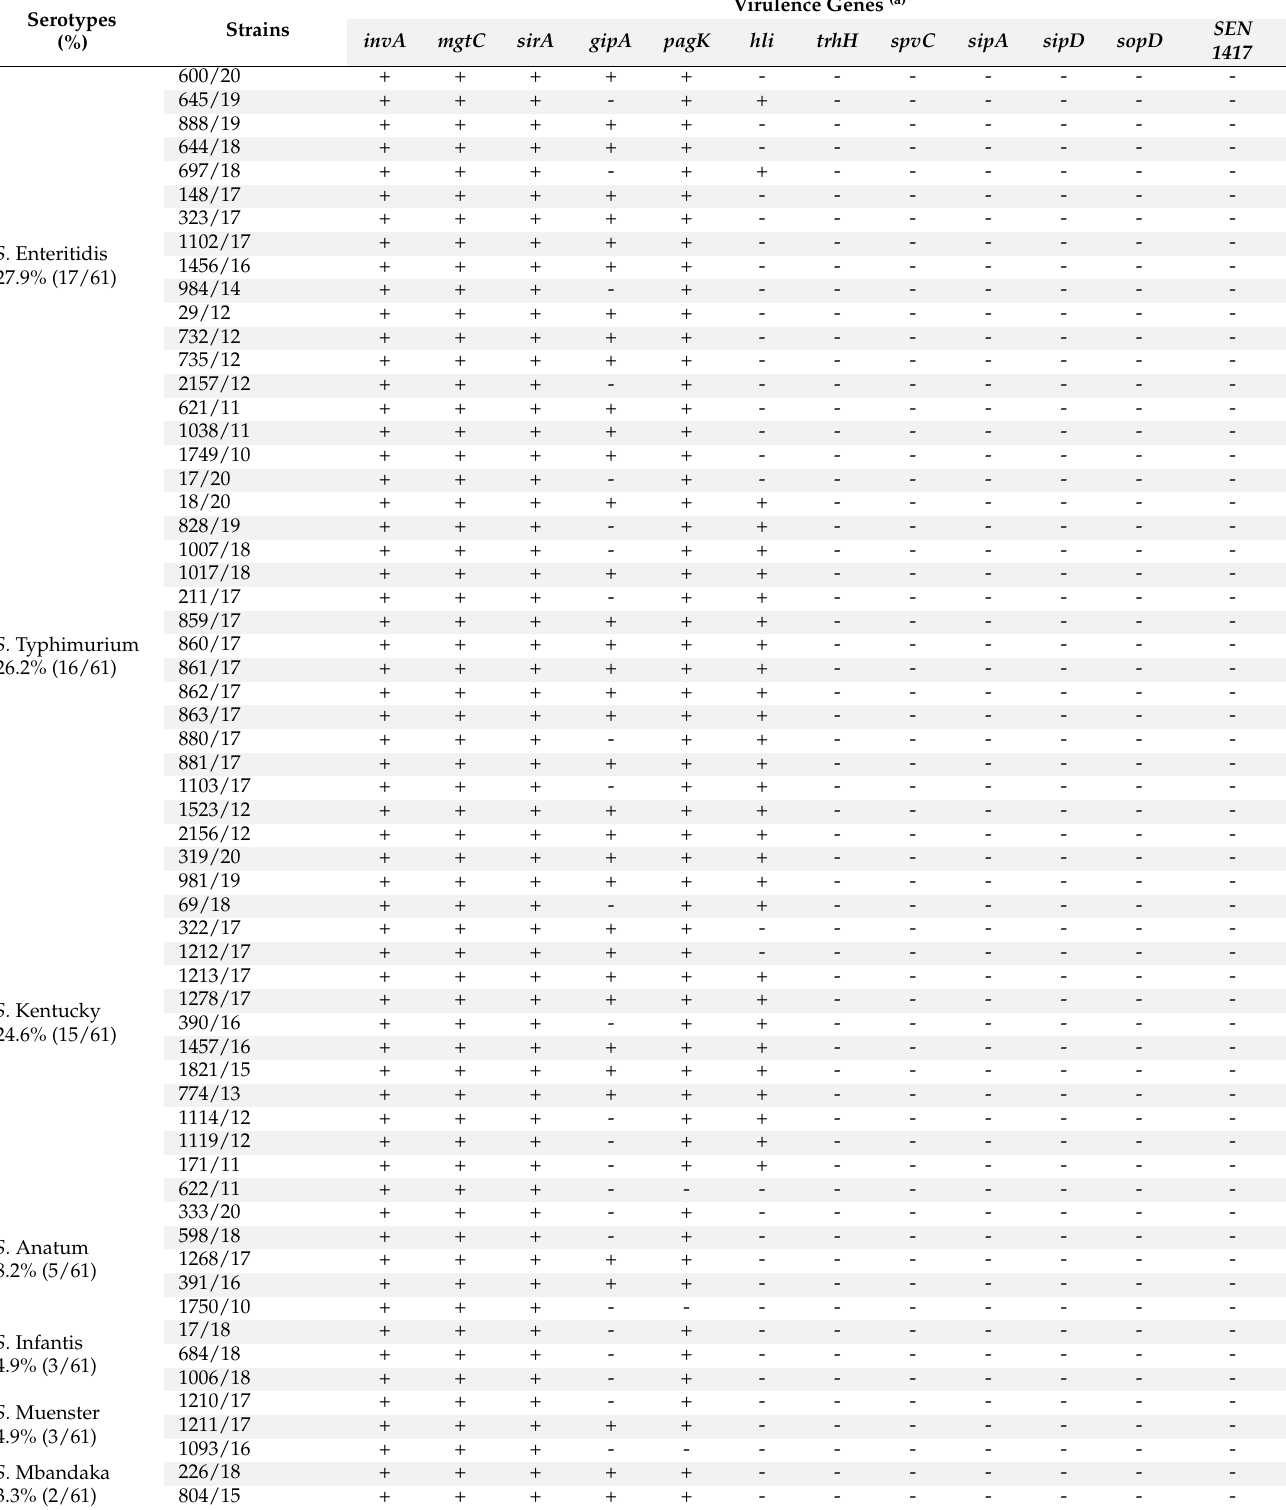
Table 1. Serotypes and virulence genes of Salmonella isolated in the present